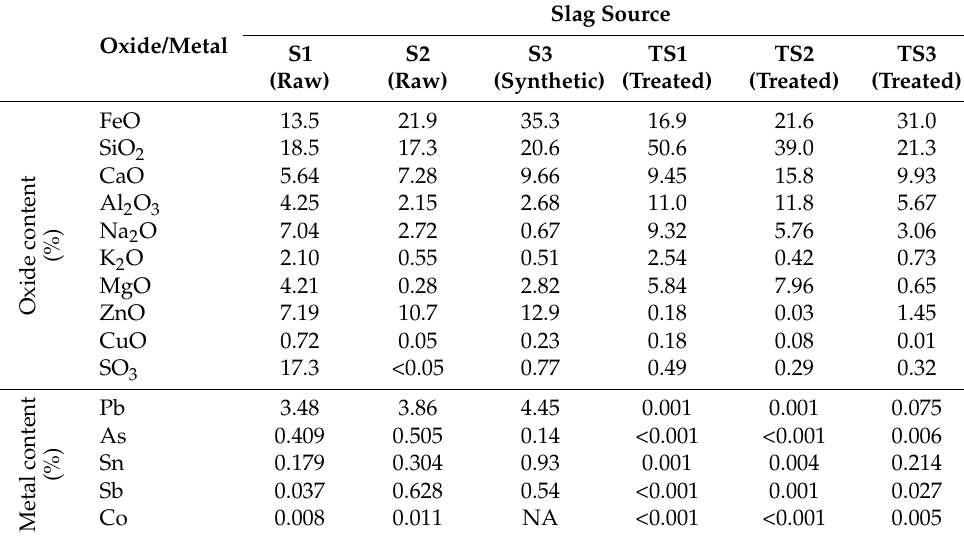
Table 1. The oxide and elemental composition of raw and treated